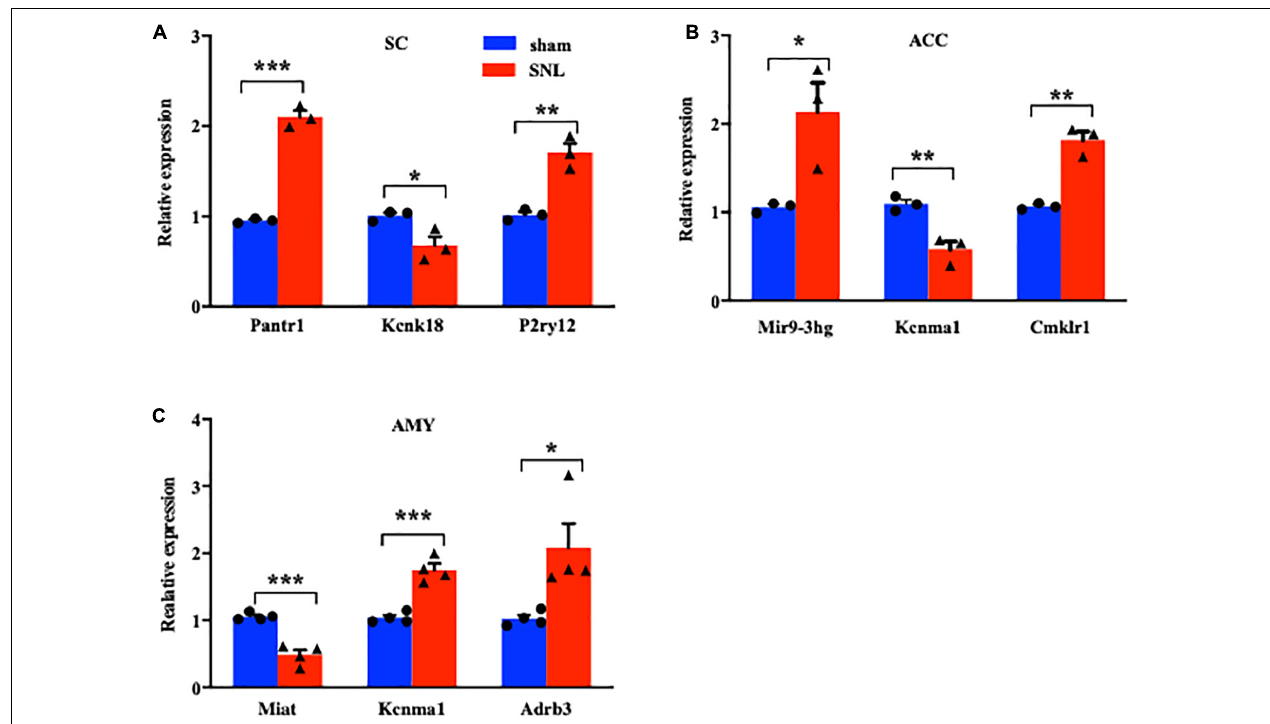
FIGURE 4 | Validations of differentially expressed lncRNAs and mRNAs in the SC, ACC, and AMY after nerve injury. (A) Levels of lncRNA Pantr1, G protein-coupled receptor P2ry12, and ion channel Kcnk18 in the spinal cord on day 7 after SNL. n = 12 mice/group. * P < 0.05; ** P < 0.01, and *** P < 0.001 versus the corresponding sham group by two-tailed unpaired Student’s t -test. (B) Amounts of lncRNA Mir9-3hg, G protein-coupled receptor Cmklr1, and ion channel Kcnma1 in the ACC on day 7 after SNL. n = 12 mice/group. * P < 0.05; ** P < 0.01, versus the corresponding sham group by two-tailed unpaired Student’s t -test. (C) Levels of lncRNA Miat, G protein-coupled receptor Adrb3, and ion channel Kcnma1 in the AMY on day 7 after SNL. n = 12 mice/group. * P < 0.05; ** P < 0.01, and *** P < 0.001 versus the corresponding sham group by two-tailed unpaired Student’s t